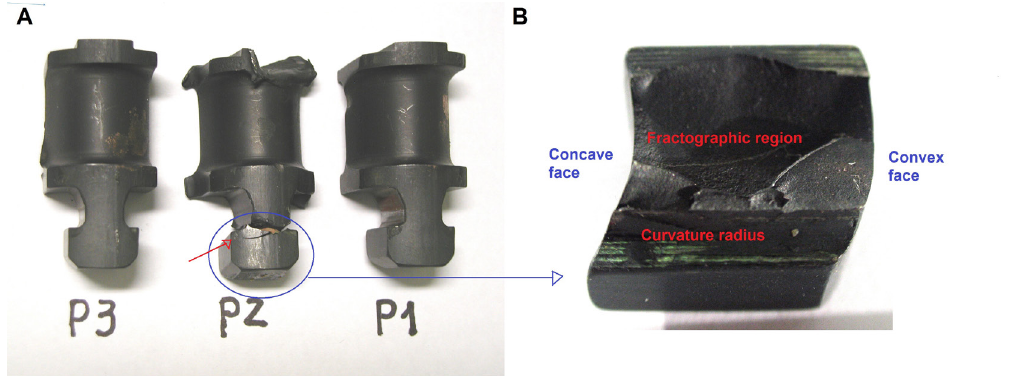
Figure 3. (A) Blades named P1 (adjacent blade), P2 (failed blade), and P3 (adjacent blade). (B) Detail of the fracture surface of the P2 blade base.